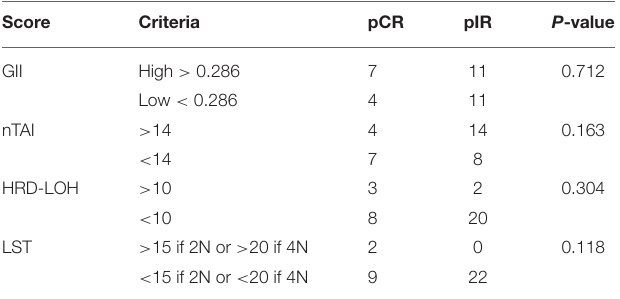
TABLE 2 | The number of cases with high Genomic Instability Index (GII) and predicted homologous recombination deficiency (HRD) based on three scores (tAI, LOH, and